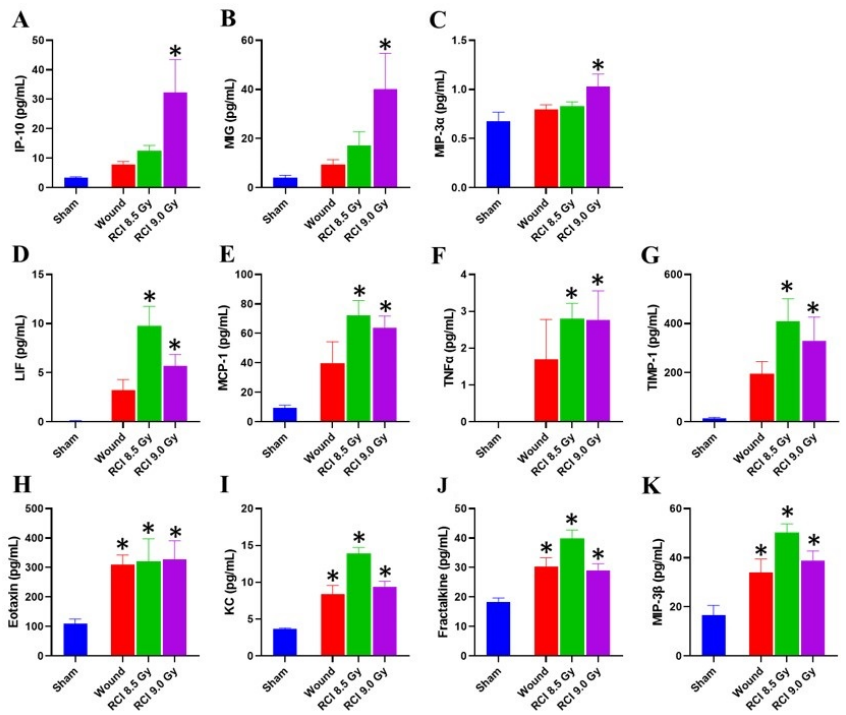
Figure 5. Chemokine levels are elevated in the skin at wound sites of 9.0 Gy RCI mice. ( A – C ) Three chemokines IP-10, MIG, and MIP-3 α were significantly elevated in skin at wound sites of 9.0 Gy RCI mice. ( D – G ) Four chemokines LIF, MCP-1, TNF α , and TIMP-1 were increased in skin at wound sites of RCI groups. ( H – K ) Other four chemokines eotaxin, KC, fractalkine, and MIP-3 β were elevated in skin at wound sites of both wound and RCI groups. * p < 0.05 for wound or RCI vs. sham by one-way ANOVA and Dunnett’s multiple comparisons test; N = 4.